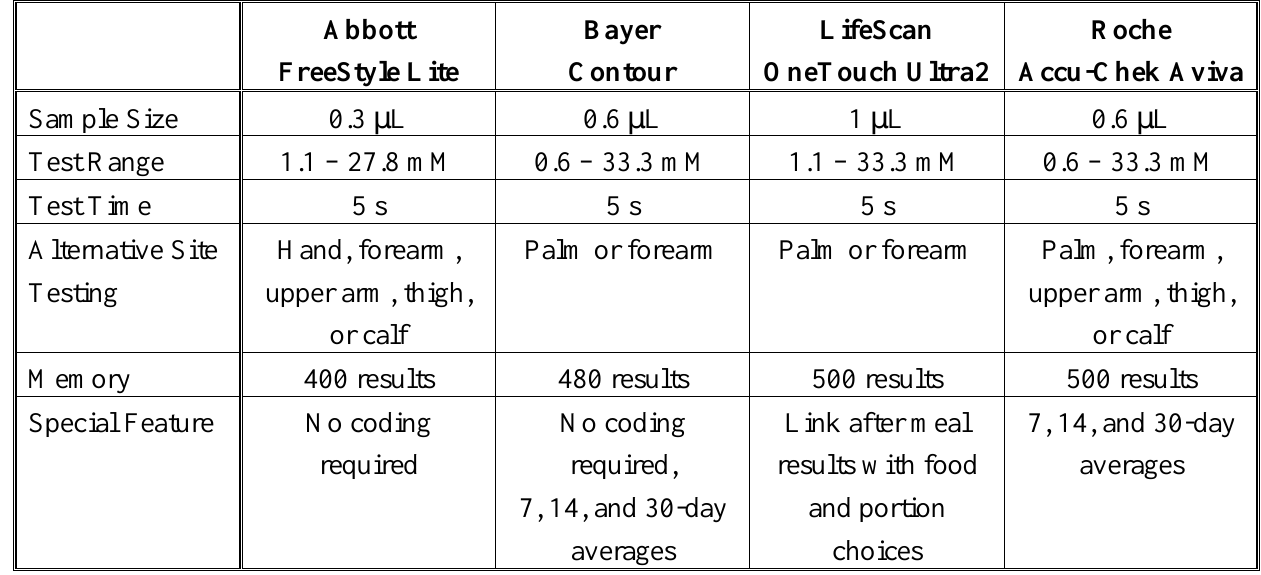
Table 1. Comparisons between four commercial fingerprick-type glucose